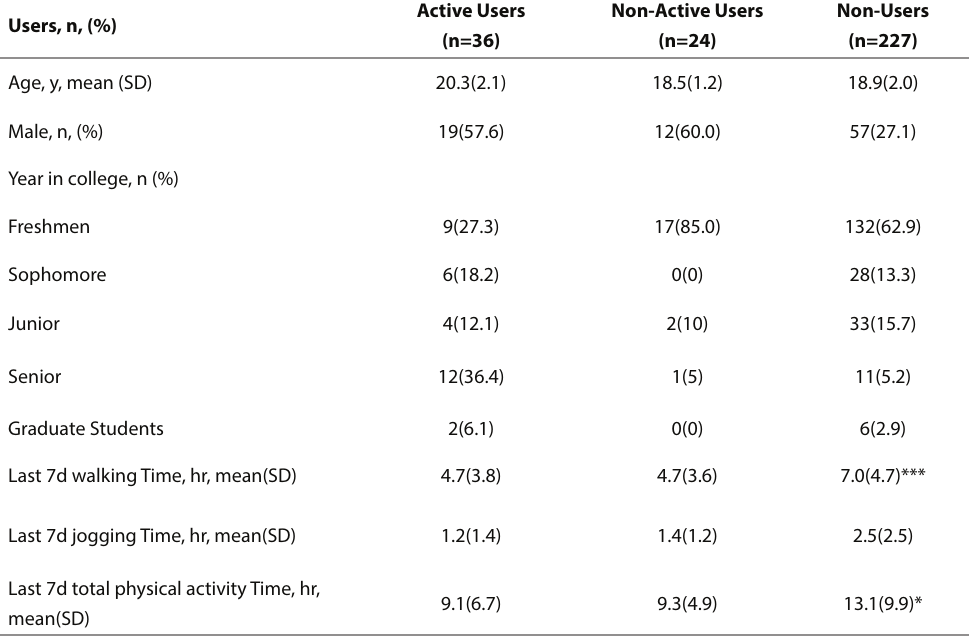
TABLE 1. Basic characteristics of the study participants